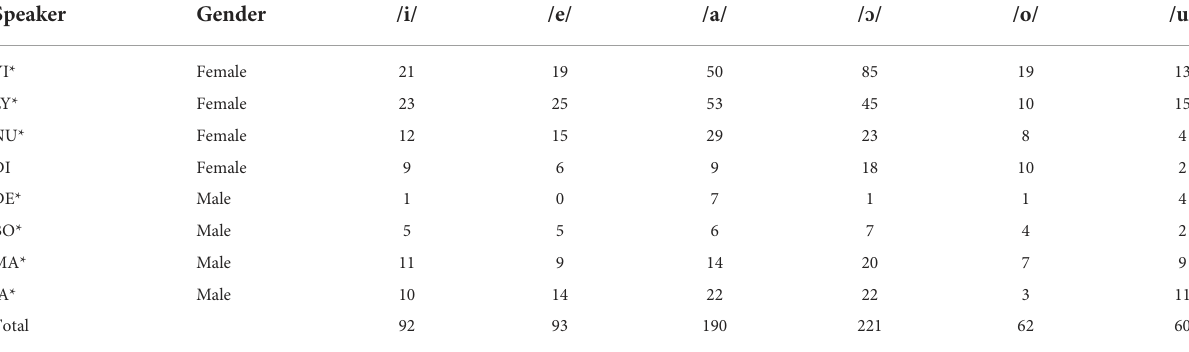
TABLE 2 Number of tokens for each vowel, by speaker, in the conversational ADS dataset. Speaker